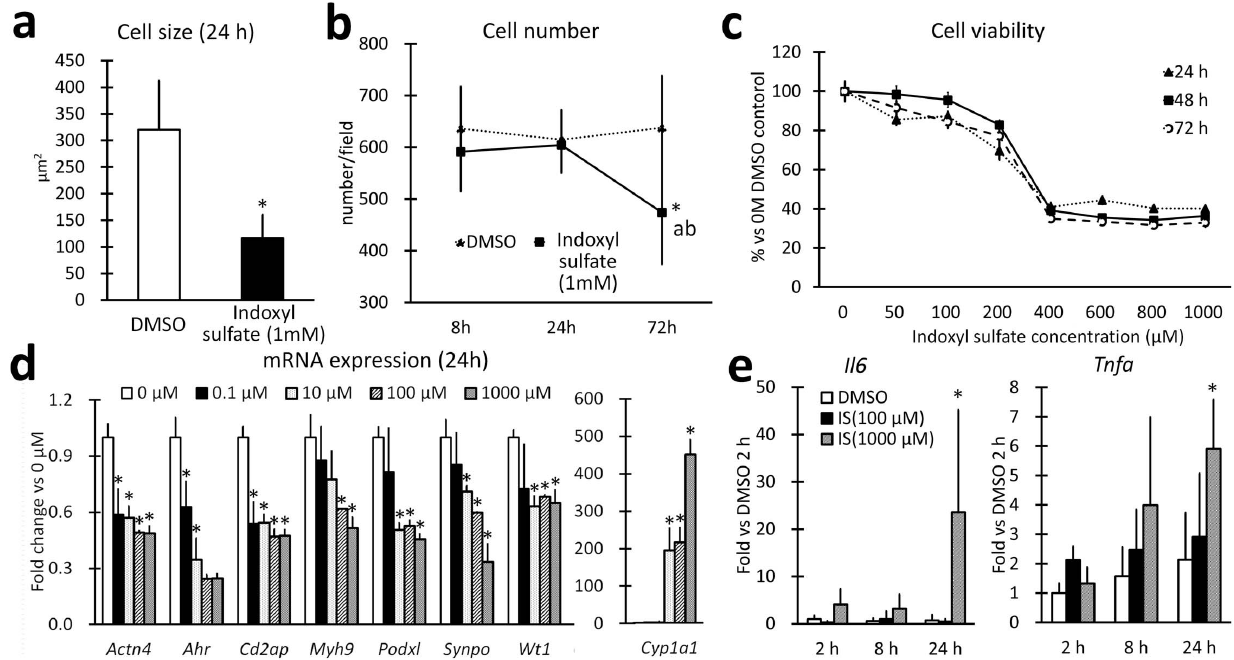
Figure 6. Indoxyl sulfate altered differentiation marker expression in mouse podocytes. The size of differentiated mouse podocytes decreased with indoxyl sulfate compared to dimethyl sulfoxide (DMSO) control; n=3, mean 6 SD ( a ). * denotes significant differences between the DMSO and indoxyl sulfate groups ( P , 0.05). Cell numbers were reduced in indoxyl sulfate-treated mouse podocytes compared to those treated with DMSO; n=3, mean 6 SD ( b ). Indoxyl sulfate-treated cells were reduced in number at 72 h compared to DMSO control (*, P , 0.05). Indoxyl sulfate- treated cells were reduced at 72 h compared to the 8 h (a, P , 0.05) and 24 h (b, P , 0.05) time points. A dose-response study showed that the viability of differentiated podocytes, assessed using an MTT assay, was reduced to a similar extent at 24, 48, and 72 h, and that the toxic effect reached a plateau at 400 m M; n=3, mean 6 SD ( c ). The baseline viability was assessed using a 0- m M control for each time group. Podocyte marker mRNA expression was reduced by indoxyl sulfate, as assessed by real-time PCR in differentiated mouse podocytes after indoxyl sulfate treatment ( d ); n=3, mean 6 S.D. Data are presented as fold increase vs. DMSO (0 m M). * denotes significant differences vs. control for each gene ( P , 0.05). RNA expression of two cytokines, Il6 and Tnfa , increased in differentiated mouse podocytes after indoxyl sulfate (IS) treatment ( e ); n=3, mean 6 S.D, fold increase vs. DMSO in each gene. * denotes significant differences vs. DMSO for each time group ( P , 0.05); h denotes hours after exposure.